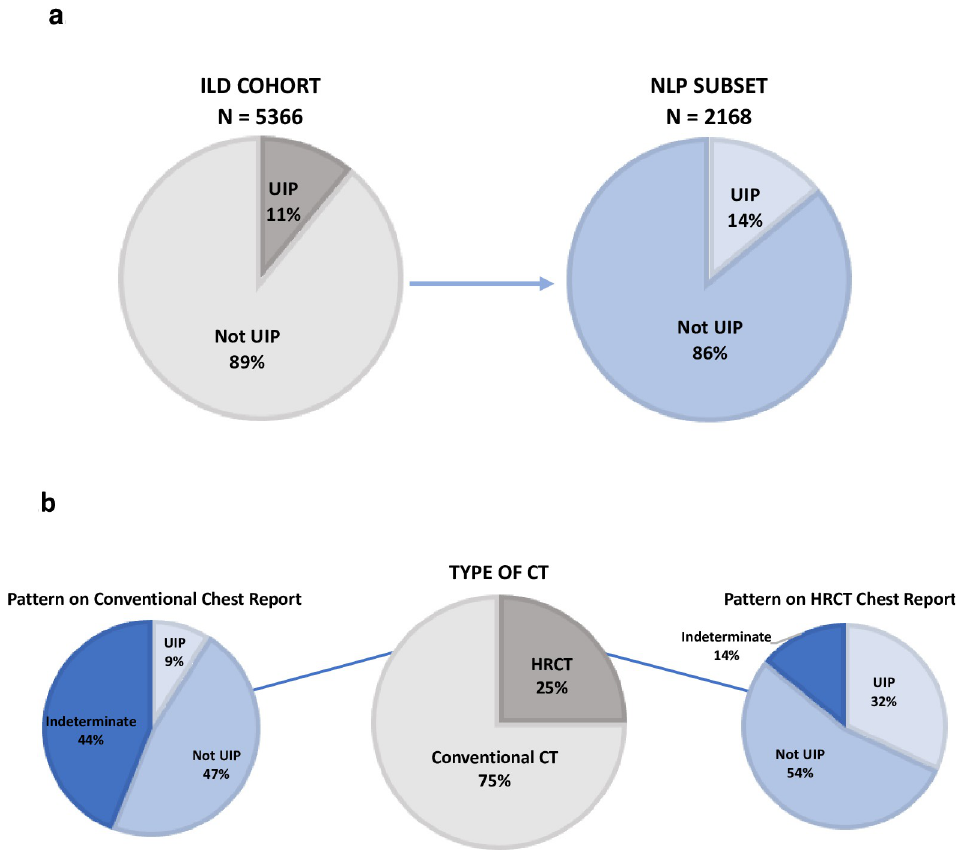
Fig 1. a . Pattern Detection on CT Chest Reports Using Natural Language Processing. Radiographic pattern detection on CT Chest reports from ILD Cohort: detection of usual interstitial pneumonia (UIP) and not UIP patterns using natural language processing (NLP) and manual validation. b . Comparison of Radiographic Patterns in HRCT vs. Conventional CT. Radiographic pattern detection on CT Chest reports from ILD Cohort: comparison of pattern detection in high-resolution CT (HRCT) reports vs. conventional CT